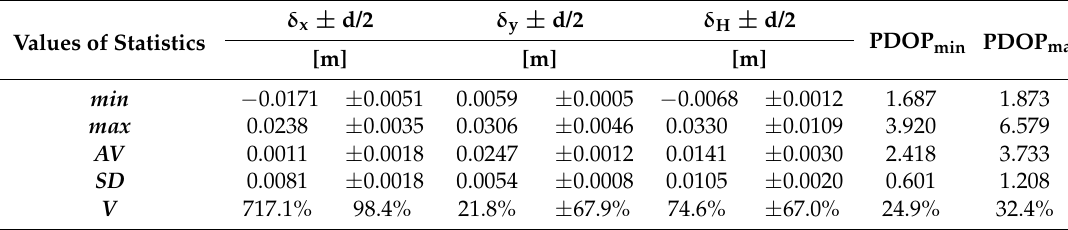
Table 10. Basic statistics for systematic errors of measurements together with the length of confidence intervals (d/2) at the confidence level of 0.95 and the minimum (PDOPmin) and maximum (PDOPmax) values of PDOP parameters for each series.